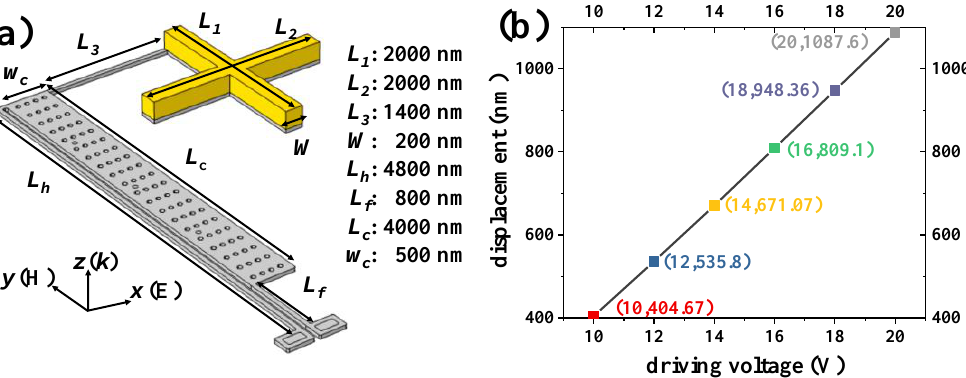
Figure 4. ( a ) Schematic drawing and geometrical dimensions of CSM unit cell. ( b ) The relationship of driving voltages and displacements of electromechanically rotatable CSM.